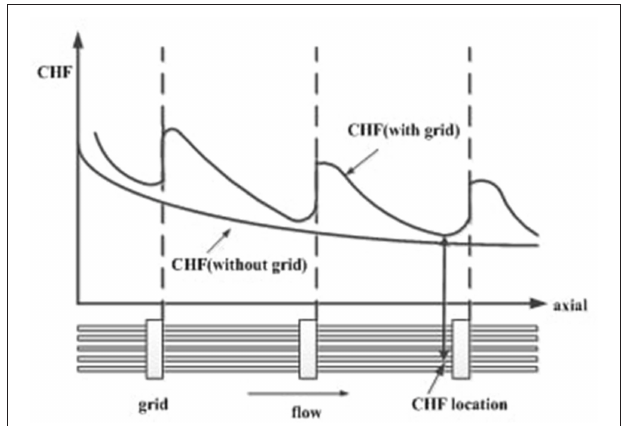
FIGURE 3 | Enhancement effect of grids on